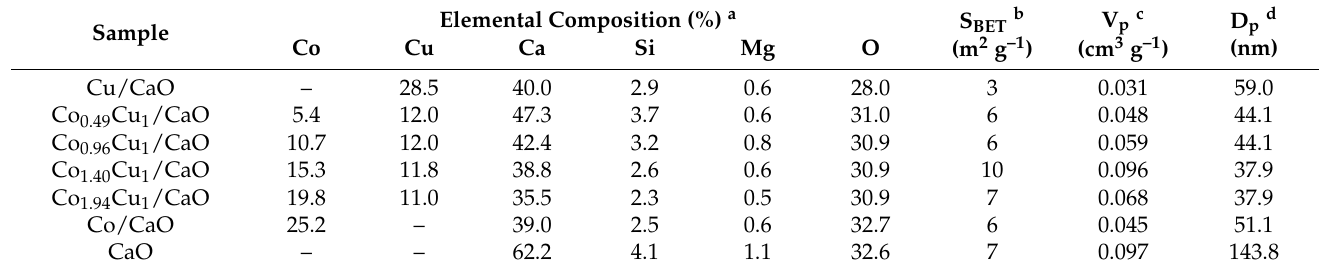
Table 3. Elemental composition and physical properties of the different